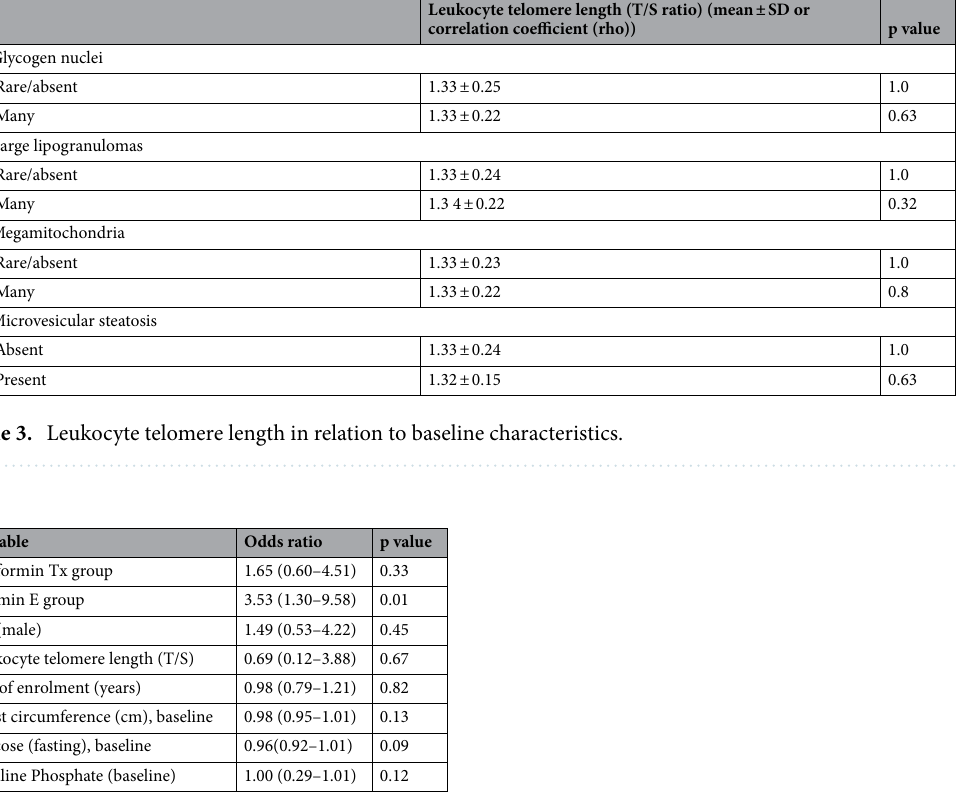
Table 4. Predictors of NASH improvement* at 96 weeks. *Based on biopsy.